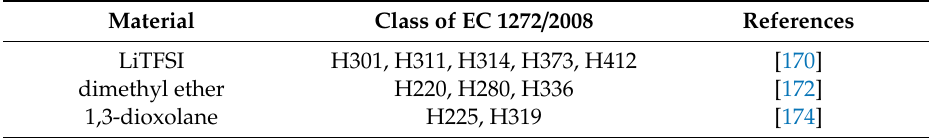
Table 5. Hazard statements of LiTFSI, dimethyl ether, and